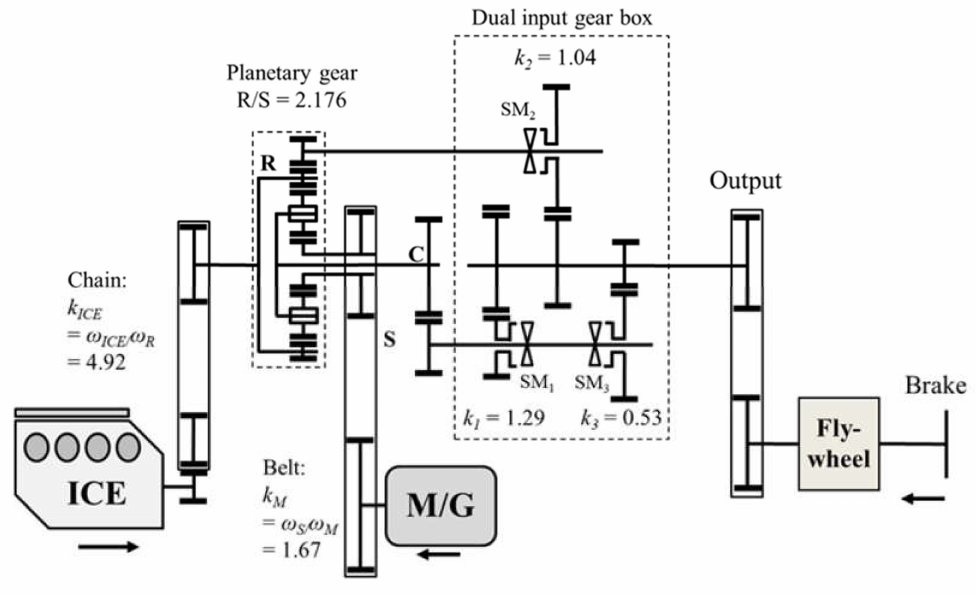
Figure 7. Structure and connecting diagram of the CGST test